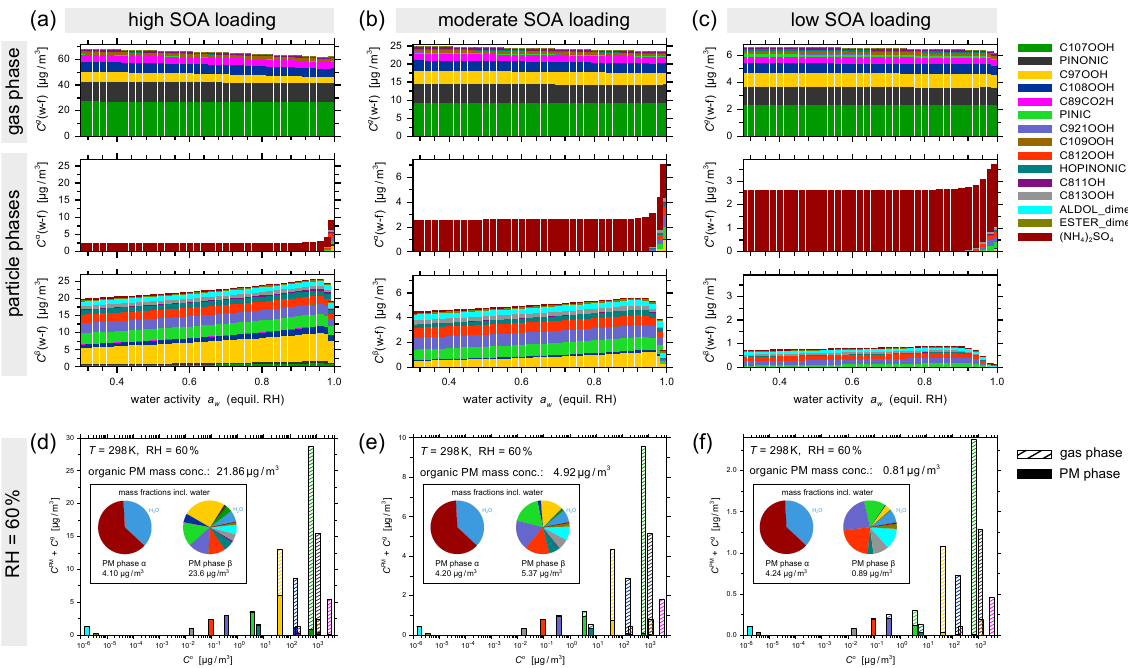
Fig. 4. Calculated gas and particle phase compositions as a function of RH (30% to 99%) at different SOA loading levels. All computations are for the benchmark equilibrium modeling case at 298K. Top panels (a, b, c) : water-free phase compositions in terms of mass concentrations per unit volume of air. At all water activities (= equilibrium RH) and SOA loading levels, the model predicts a liquid-liquid phase separation of the PM into a predominantely aqueous ammonium sulfate phase α and a predominantely aqueous organic phase β . Bottom panels (d, e, f) : the gas-particle partitioning of each organic compound at 60% RH as a function of the SOA loading level and its pure compound saturation concentration C ◦ . The pie-charts (insets) reveal the mass fractions of water associated with the two liquid